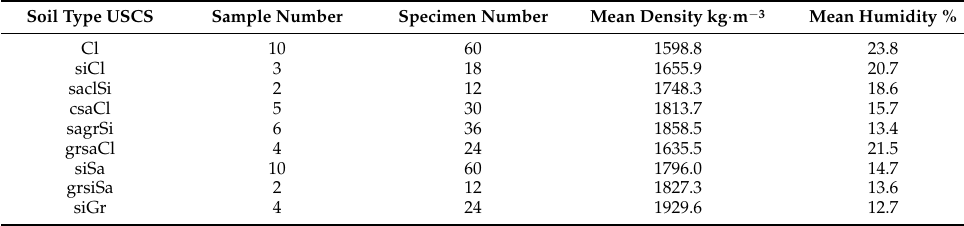
Table 1. Sample classification and the corresponding mean values of density and